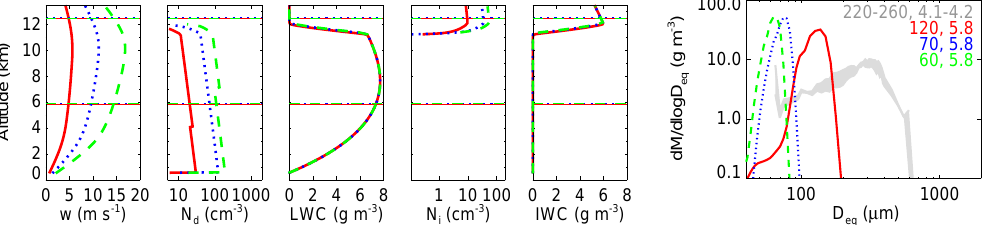
Figure 4. Profiles of parcel updraft speed ( w ), water drop concentration ( N d ), liquid water content (LWC), ice particle concentration ( N i ), and ice water content (IWC), and ice particle size distribution (PSD) at output level nearest − 40 ◦ C for simulations with droplet activation, diffusional growth, and homogeneous drop freezing only, and baseline updraft strength scaled by factors of 0.5 (red solid line), 1.0 (blue dotted line), and 1.5 (green dashed line), Shaded area in PSD panel is envelope of median Airbus PSDs from Cayenne and Darwin for IWC > 4gm − 3 (see Fig. 6 of Part 1). Horizontal lines in profiles correspond to 0 and − 40 ◦ C. PSD is plotted in terms of ice particle mass ( M ) and area-equivalent diameter D eq . The numbers in the upper right of the PSD panel are MMD eq in units of µm and IWC in units of gm − 3 for the IWC-filtered measurements (in gray) and correspond to simulation results with same line color. MMD eq from simulations are rounded to nearest 5µm to reduce attention to smaller differences attributable to variations in height resulting from 10s output frequency.